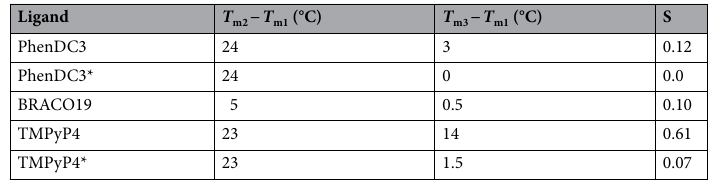
Table 3. The stabilizing effect of the three ligands on HepB. Results of the competition assay. (Modified from Ref. 64 ). T m2 − T m1 = increase of HepB_FRET when adding the ligand in twofold excess. T m3 − T m1 = increase of the transition midpoint when both the ligand and the unlabeled HepB were added. S = ( T m3 − T m1 )/( T m2 − T m1